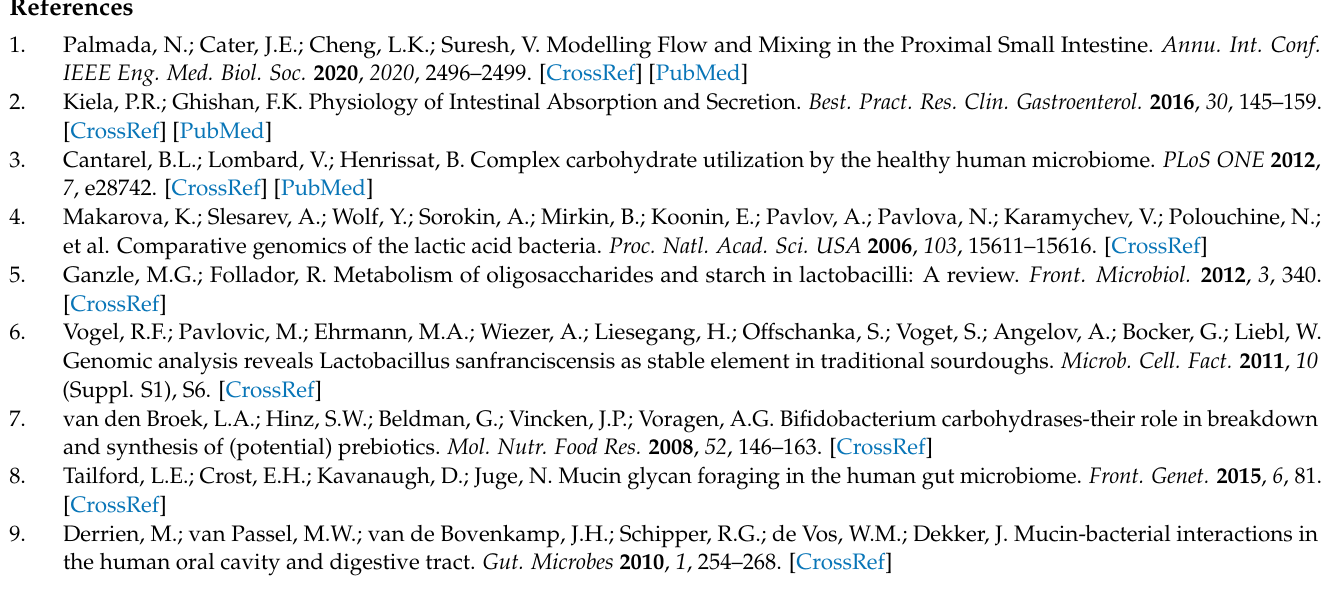
after qc steps. Table S2: 16S rRNA sequence enumeration. Table S3: Modulatory capacity of prebiotics and medicinal herbs at the phylotype level. Table S4: Statistical analysis of significant changes in taxa at the family level. Table S5: Pairwise analysis of prebiotics and medicinal herbs. Table S6: Changes in GH/PL representation by common and distinct sugar composition and structures of